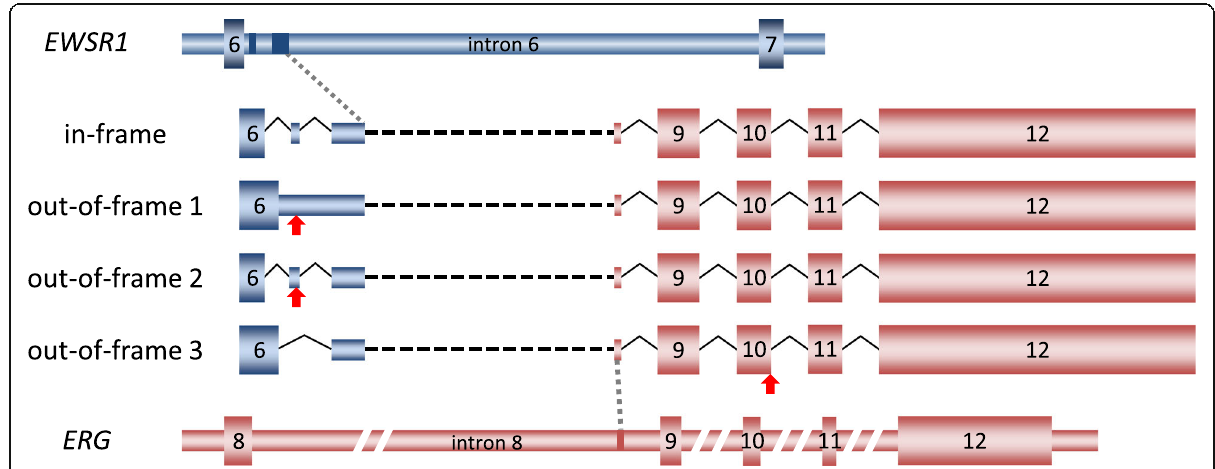
Fig. 5 Schematic representations of the fusion transcripts in tumor 4. Scheme of the transcript variants of EWSR1-ERG . The blue boxes in intron 6 of EWSR1 and red box in intron 8 of ERG indicate cryptic exons found in the in-frame variant. The red arrows in out-of-frame variants are sites of the termination codon. EWSR1 and ERG are connected by black dotted